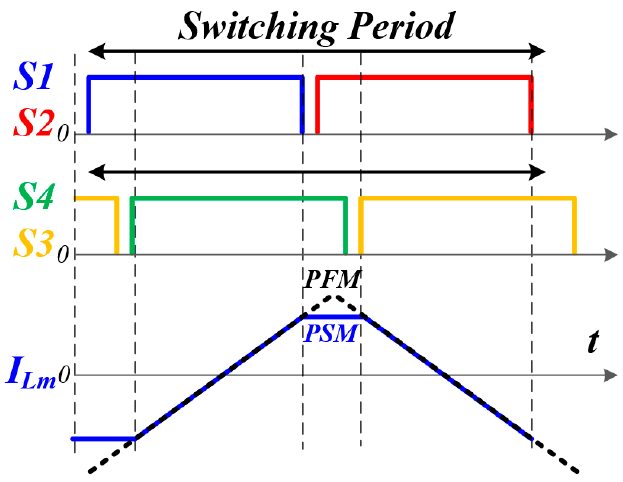
Figure 5. Circulating current decrement using phase shift modulation (PSM).